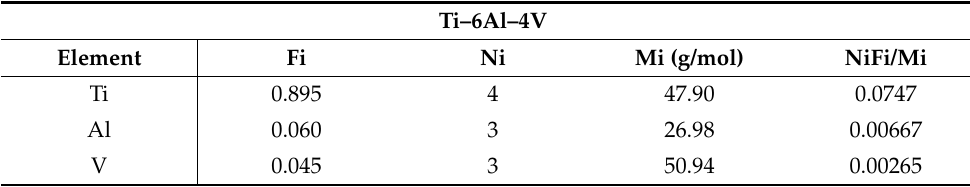
Table 1. Ti–6Al–4V alloy equivalent weight calculation.